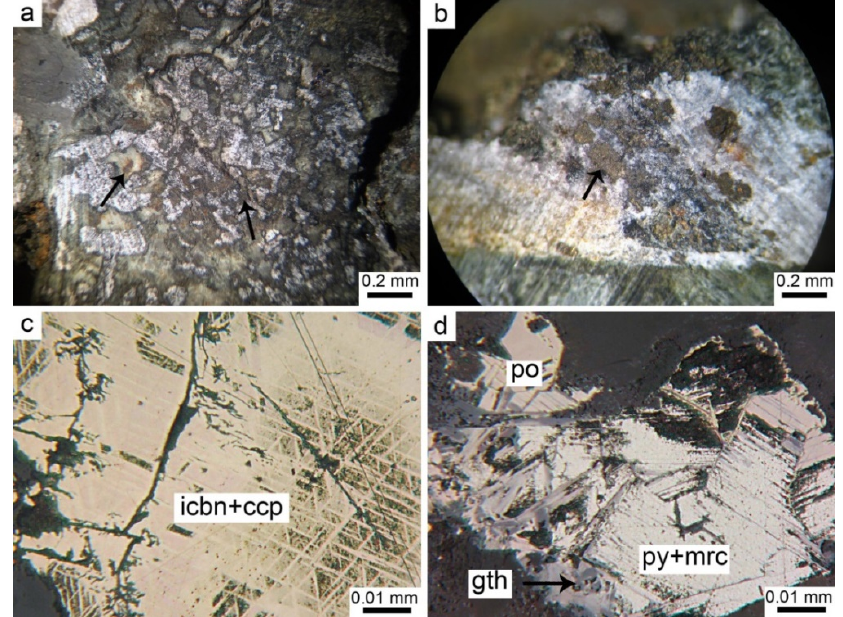
Figure 4. Disseminated Cu–Fe sulfides (indicated by arrows) in strongly altered gabbro with aragonite veinlets (white) ( a , b ); isocubanite)–chalcopyrite aggregate with typical lattice structure ( c ); crystalline pyrrhotite (po) replaced by fine pyrite–marcasite aggregates and rimmed by goethite (gth) ( d ). Photos ( a , b ), binocular microscope; ( c , d ), reflected light.